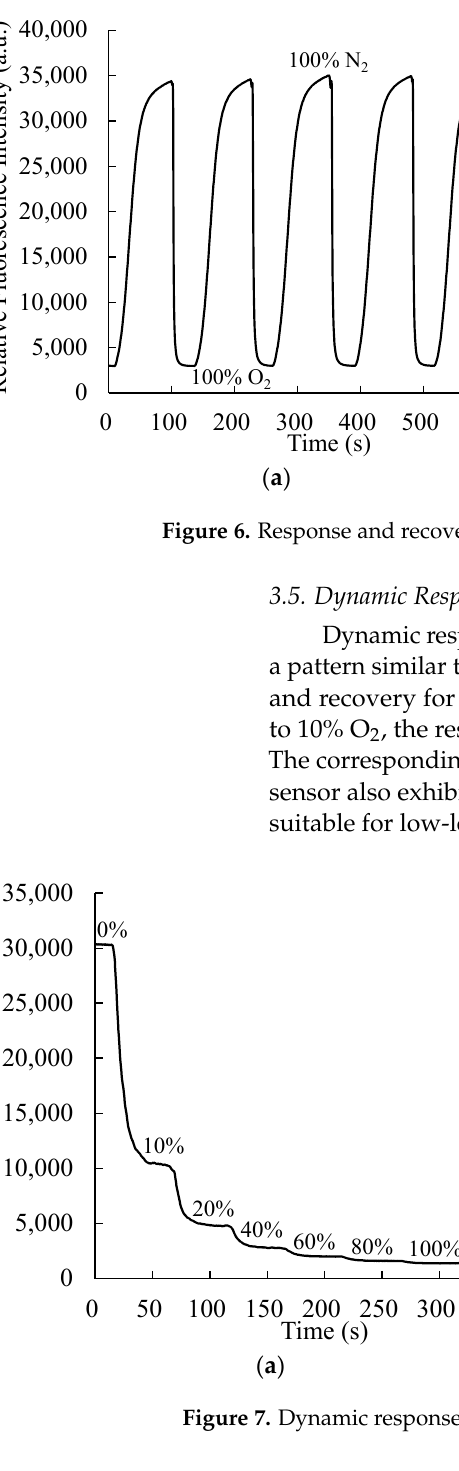
Figure 7. Dynamic response times of the optical dual sensor for ( a ) O 2 and ( b ) CO 2 .